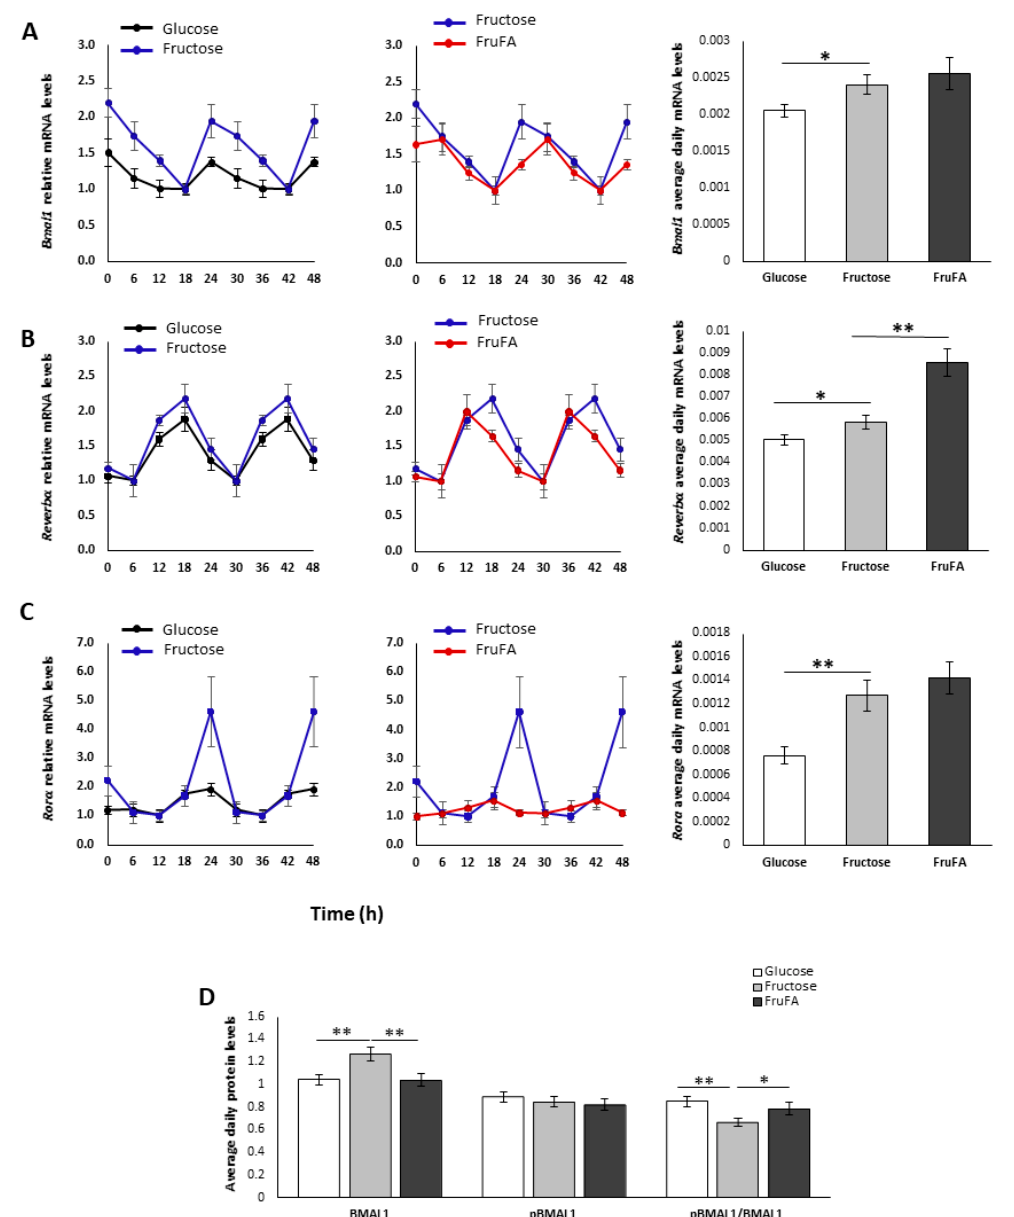
Figure 4. Effect of fructose and fructose-induced steatosis on the circadian Bmal1 - Rev-erb α - Ror α axis in AML-12 hepatocytes. ( A ) Expression and average daily levels of Bmal1 mRNA. ( B ) Expression and average daily levels of Rev-erb α mRNA. ( C ) Expression and average daily levels of Ror α mRNA. ( D ) Average daily protein levels of BMAL1, pBMAL1, and the pBMAL1/BMAL1 ratio. One hundred and fifty thousand cells per mL were used in each treatment. Values are means ± SE. Asterisks denote significant differences by t -test (* p < 0.05; ** p <